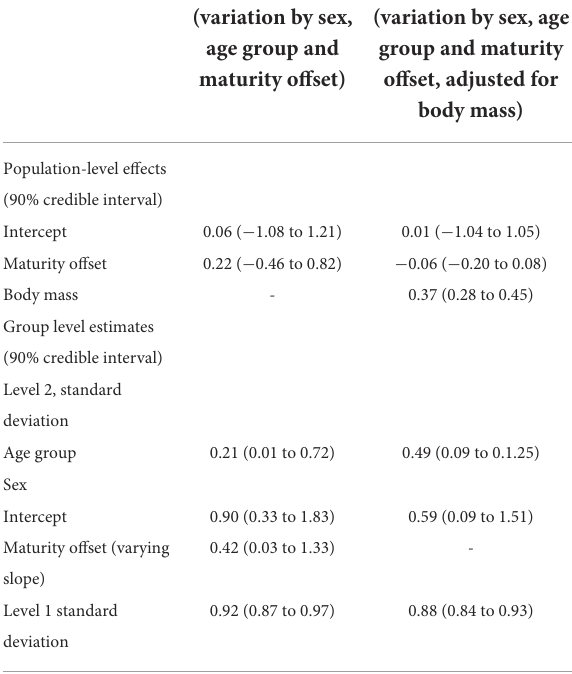
TABLE 5 Multilevel regression models posterior estimations and 90% credible intervals of variation in phase angle by sex, age, group, maturity offset (model 3), and adjusting for body mass (model 4) among